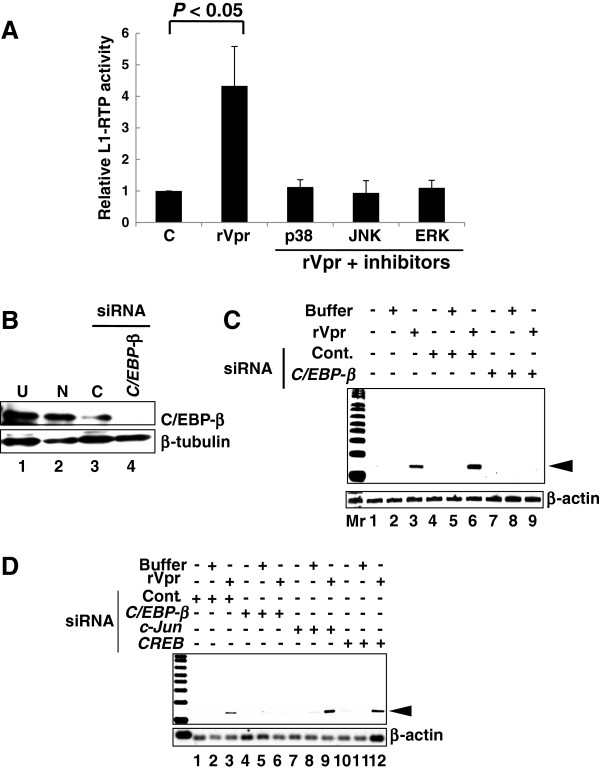
Involvement of MAPK in rVpr-induced L1-RTP. A. Inhibition of rVpr-induced L1-RTP by MAPK inhibitors. Before addition of rVpr, SB202190, SP600125 and PD98059, which were inhibitors of p38, JNK and ERK, respectively, were added. Results of the qPCR assay was shown. B. Expression of endogenous C/EBP-β is reduced by siRNA application. See also Additional file 10: Figure S8E showing results obtained by different siRNA. Lane 1, untreated (U); lane 2, mock transfectant (N); lane 3, control siRNA (C); lane 4, C/EBP-β siRNA. C. Inhibition of rVpr-induced L1-RTP by C/EBP-β siRNA. Mr, molecular weight marker. D. c-Jun and CREB were dispensable for rVpr induced L1-RTP. rVpr induced L1-RTP was investigated after the introduction of siRNAs targeting c-Jun and CREB. C/EBP-β siRNA was included as positive control. This experiment was done using C/EBP-β siRNA different from that used in Figures 6B and C. Effects of each siRNA on the expression of endogenous proteins were depicted in Additional file 10: Figures S8F and S8G.